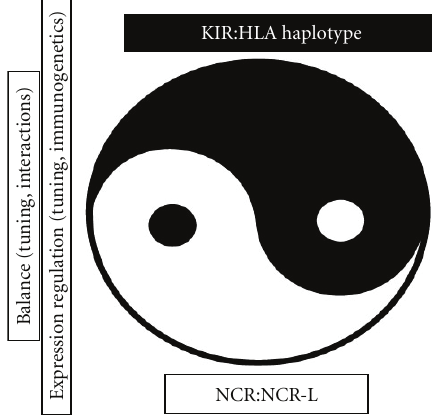
Figure 1: Diagram resuming the balance of activating and inhibi- tory NK cell receptor:ligand